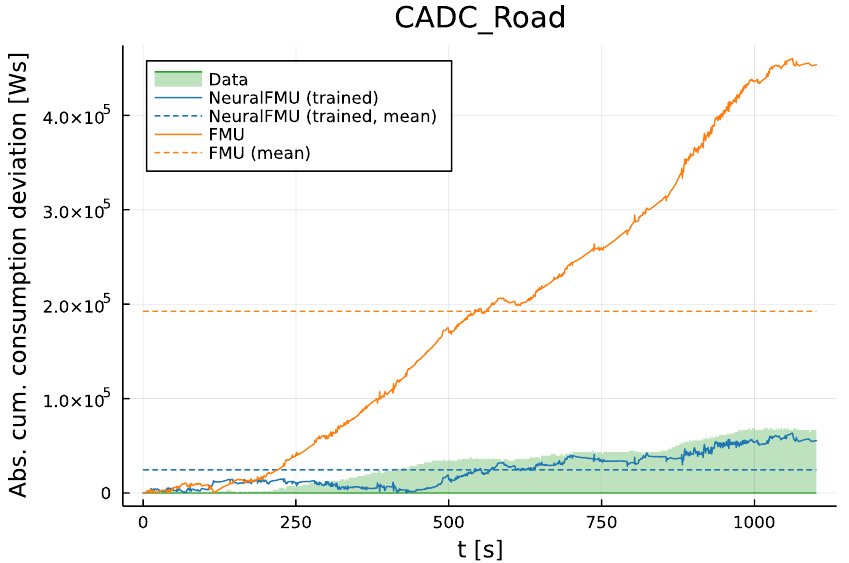
Figure 12. Deviation (absolute error) of the consumption prediction between data and the NeuralFMU (blue) compared to the original FPM/FMU (orange) on the CADC Road , which is part of the training data. After ≈ 300 s, the NeuralFMU solution lies inside the data uncertainty region (green, translucent) and outperforms the FPM in terms of prediction accuracy. Further, the NeuralFMU error is at any time step significantly smaller than the mean error of the FMU (orange,